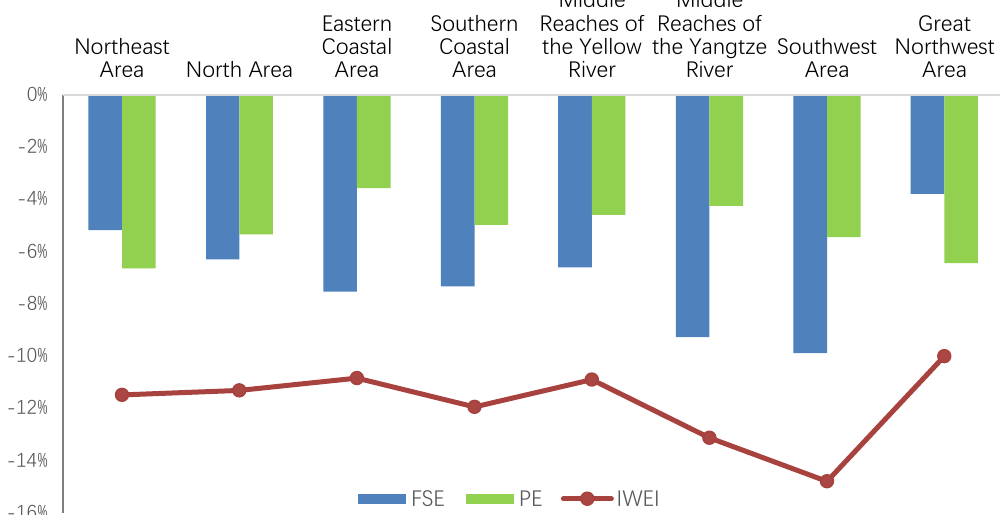
Figure 5. Regional differences in the driving factors of changes in industrial wastewater emission intensity, 2003–2015. PE: productivity effect; FSE: factor substitution effect; IWEI: industrial wastewater emission intensity.